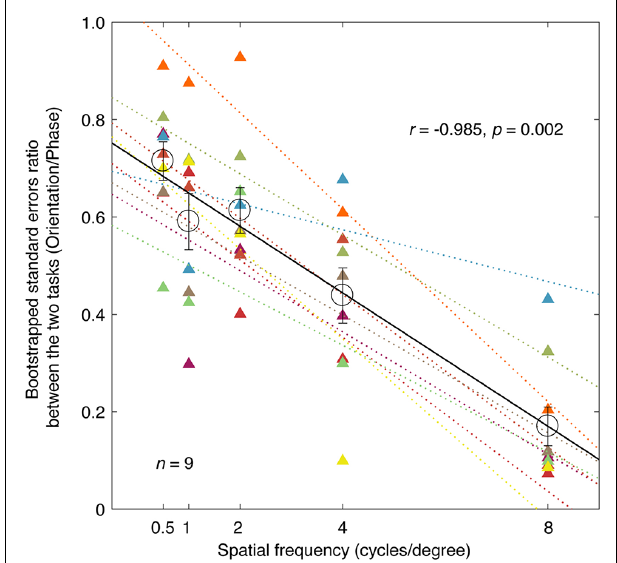
FIGURE 3 | A comparison of the precision of the two tasks; the relationship between the ratio of the bootstrapped SEs and spatial frequency. Each circle represents an averaged SE ratio (orientation / phase) of the PSE across nine subjects at one spatial frequency. Individuals’ results are also provided for each spatial frequency using triangle symbols. The best linear fits for individuals and means are provided with colored dashed lines and black solid line, respectively. Regression analysis results are provided in the figure. Error bars represent SEs across the nine subjects.